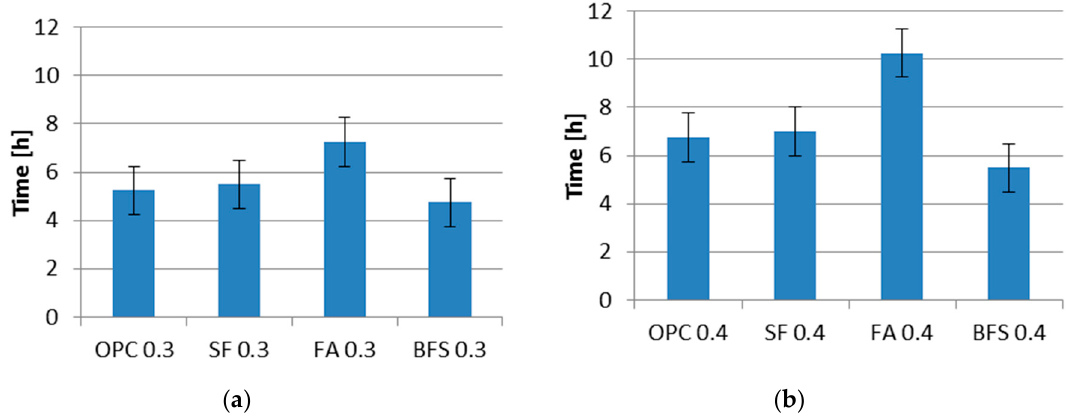
Figure 6. Final setting time of cement pastes with different supplementary materials. Code: See Table 3; ( a ) Water–cement ratio of 0.3; ( b ) Water–cement ratio of 0.4.